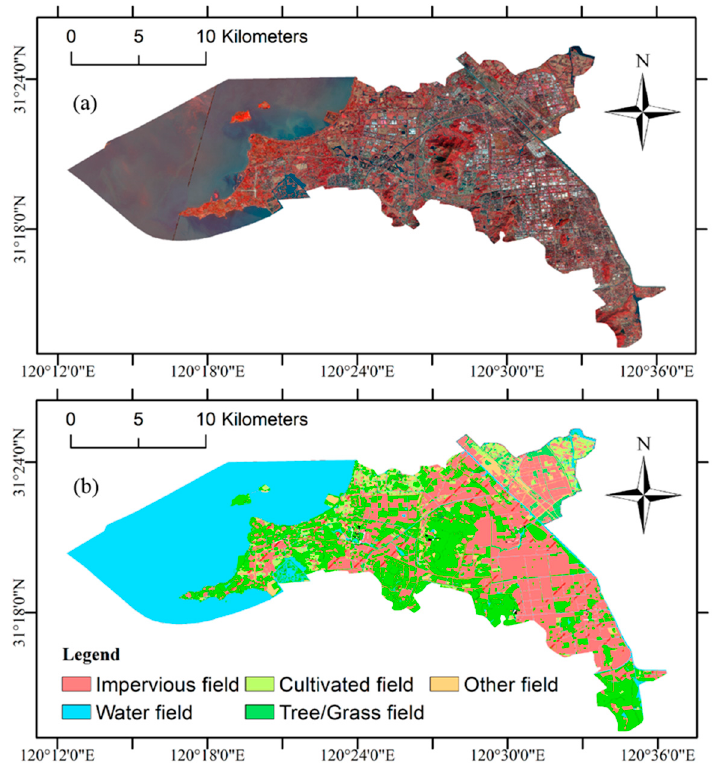
Figure 11. Large area experiment and its mapping results: ( a ) experimental GF-2 remote sensing image (15 October 2018) of Gaoxin District, Suzhou City; ( b ) the updated result of the 2018 LC map using the proposed approach.